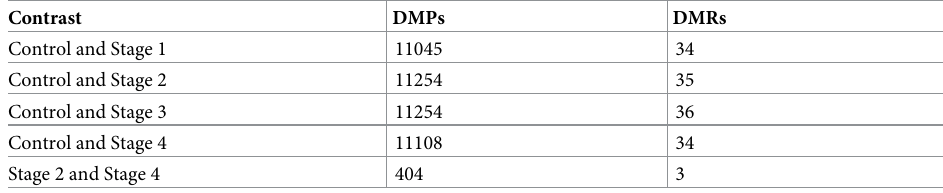
Table 4. Contrast-wise counts of DM probes and DM